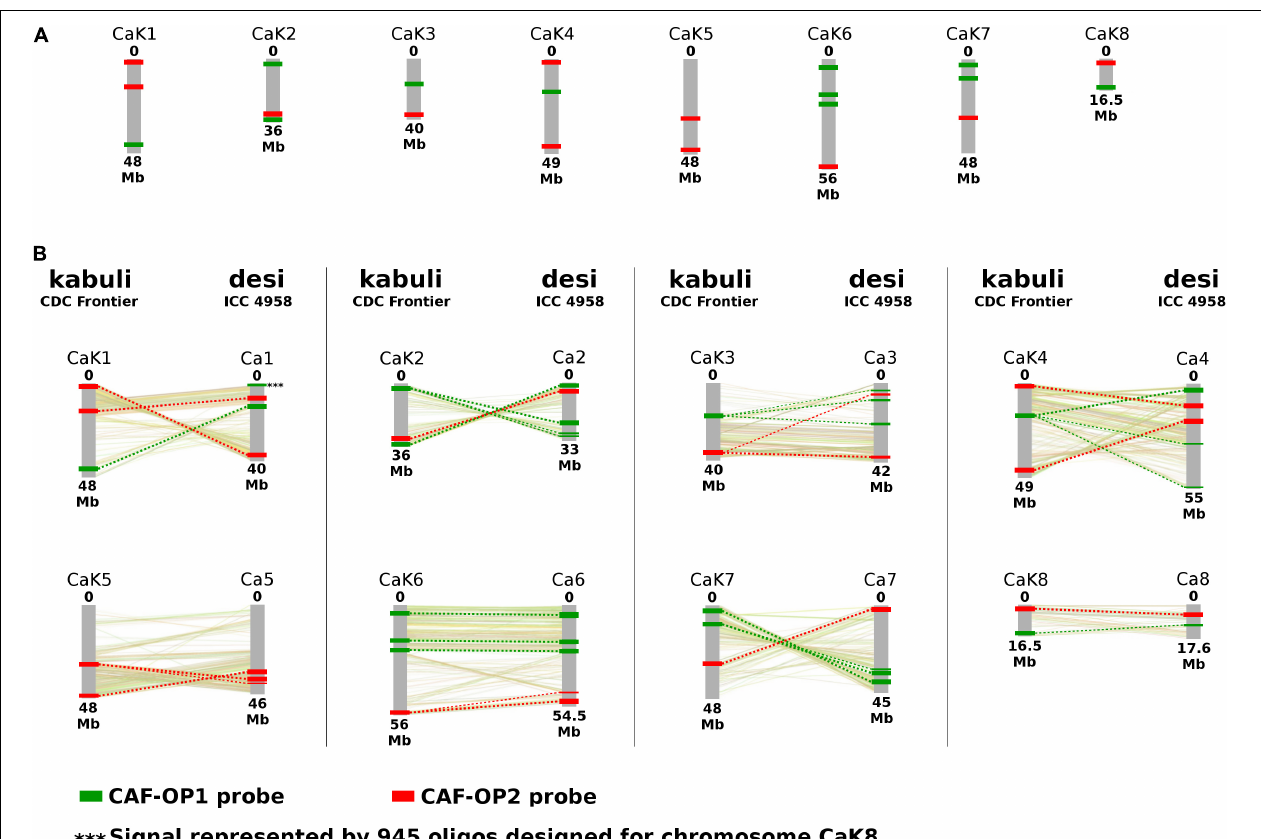
FIGURE 1 | Location of oligopainting barcodes CAF-OP1 (green) and CAF-OP2 (red). (A) Oligopainting barcodes were identified and selected by Chorus software on a reference genome assembly of Cicer arietinum CDC Frontier (kabuli type). (B) Schematic comparison of in silico predicted positions of oligopainting barcodes on